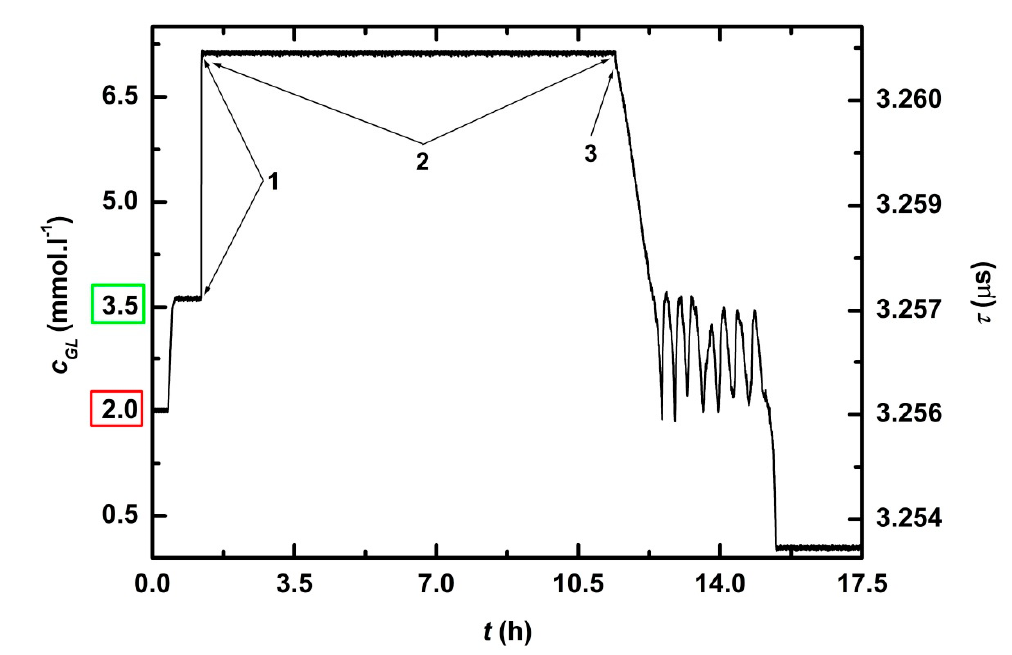
Figure 5. Time record of glucose concentration during fed-batch cultivation of Saccharomyces cerevisiae . After two-point calibration ( c GLDES = 3.5 mM, c GLMIN = 2 mM), glucose was added to complete YPG medium ( c GL = 111 mM), which was out of the range (0-7 mM) of the biosensor (position 1). The bioreactor was inoculated with an overnight culture of Saccharomyces cerevisiae and the feedback regulation was switched on (position 2). After 11.5 h of fermentation, c GL dropped below 7 mM (position 3).